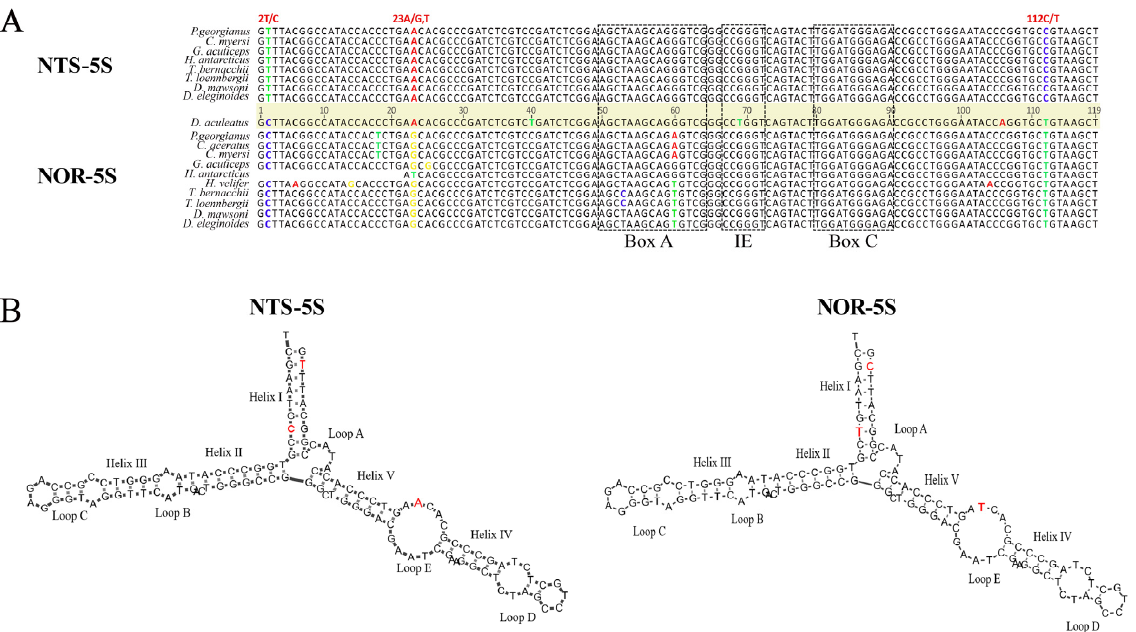
Figure 2. Comparison of the canonical 5S rRNA gene (NTS-5S) and the 5S rRNA gene inserted in IGS (NOR-5S) structures. ( A ) Alignment of NTS-5S and NOR-5S rRNA gene consensus sequences of Nototheniidae fish. Nucleotide substitutions at positions 2, 23, and 112 distinguishing two variants of the 5S gene are highlighted. Components of the internal control region (ICR), namely the A-box, the C-box, and the intermediate element (IE), are outlined with dotted rectangles. ( B ) Secondary structures of the Nototheniidae consensus NTS-5S and NOR-5S rRNA molecules predicted using the Andronescu’s RNA energy model at +37 °C according to [46]. The different nucleotides in the two 5S rRNA variants are marked in red.